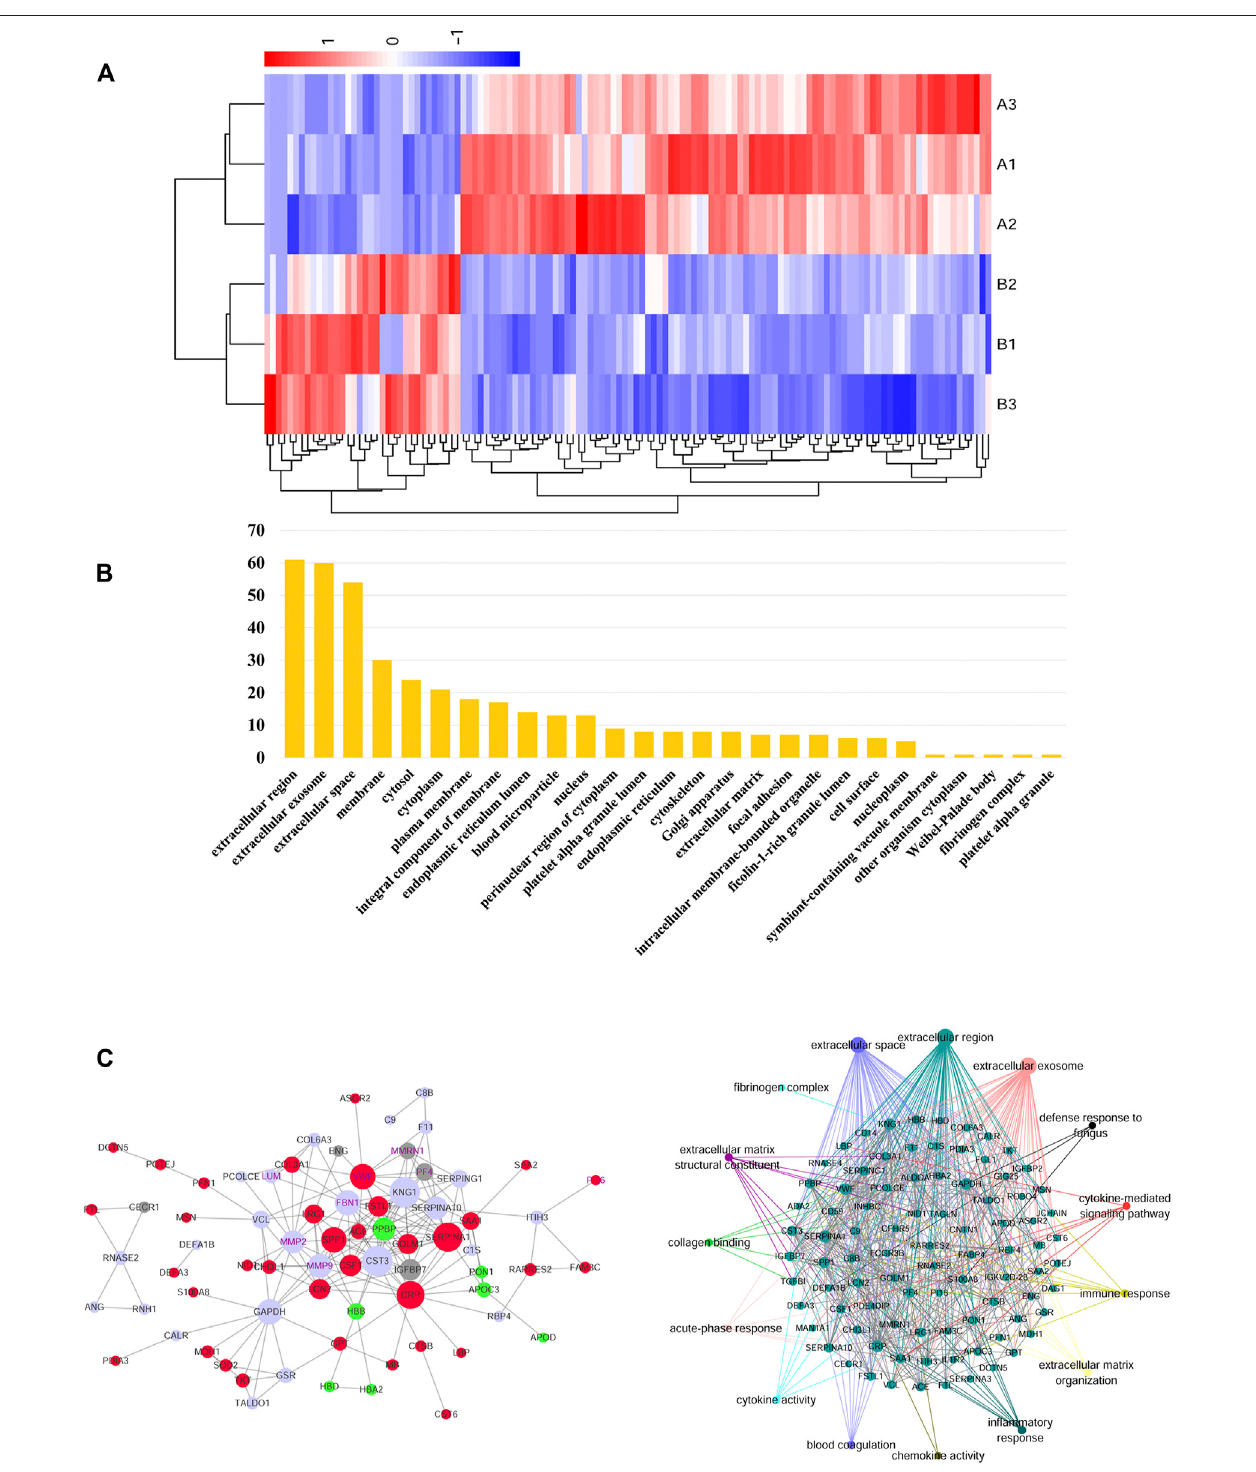
FIGURE4|(A) Intheheatmapofthe127differentialmetabolitesinAADandACS,thecolorschangingfrombluetoredindicatemoremetabolites.Inthecorrelation network of metabolites with | r | > 1, red plots indicate upregulated metabolites and blue plots indicate downregulated metabolites in the two groups. (B) Bioinformatics analysis for the differentially expressed proteins in the AAD and ACS group. Diagram showing the biological process (BP) and cellular component (CC) of differentially expressed proteins of the two groups using the DAVID analysis. (C) Network of AAD VS. ACS clustered by the Ingenuity Pathway Analysis. Protein – protein interaction was generated by Cytoscape between the AAD vs. ACS group.